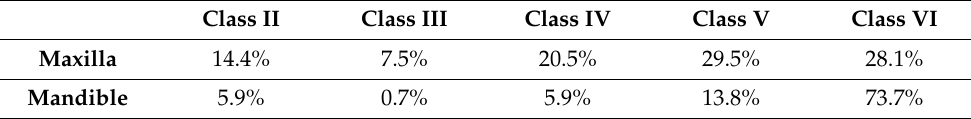
Figure 3. Diagrammatic summary of the Cawood and Howell Classification for the Maxilla ( above ) and the Mandible ( below ). Table 3. Percentage and number of cases in each subgroup of the Cawood and Howell Classification.